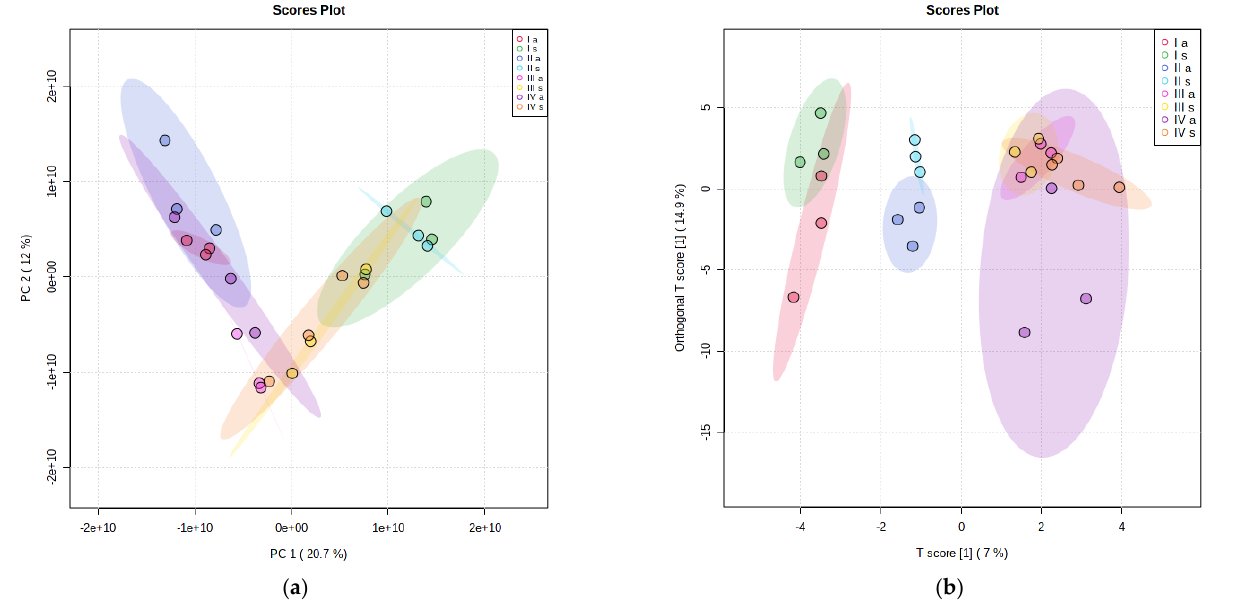
Figure 8. PCA ( a ) and OPLSDA ( b ) analysis of metabolite network of biolayers from Ruskeala quarry (united for active vegetation stage and late vegetative stage).